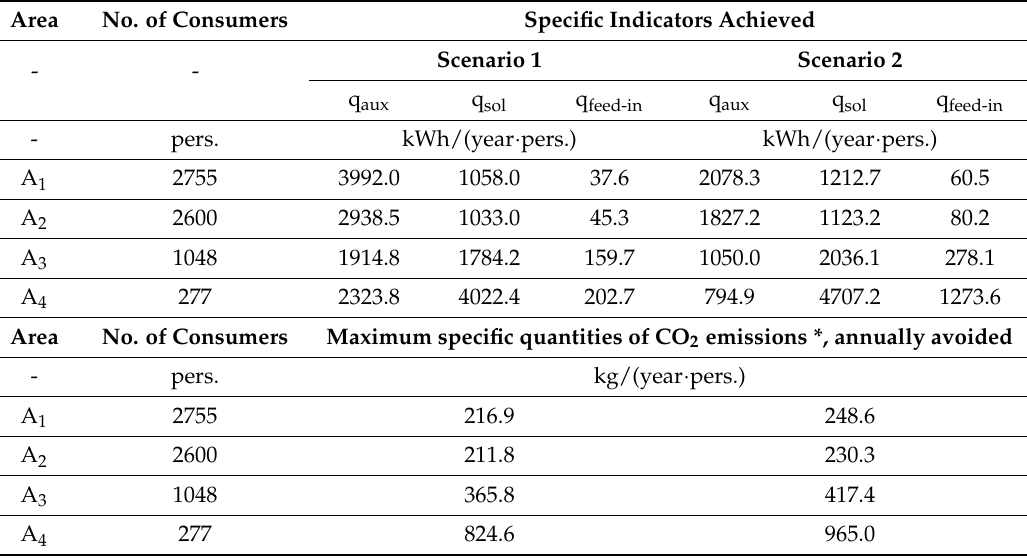
Table 11. Areas A 1 –A 4 . Specific